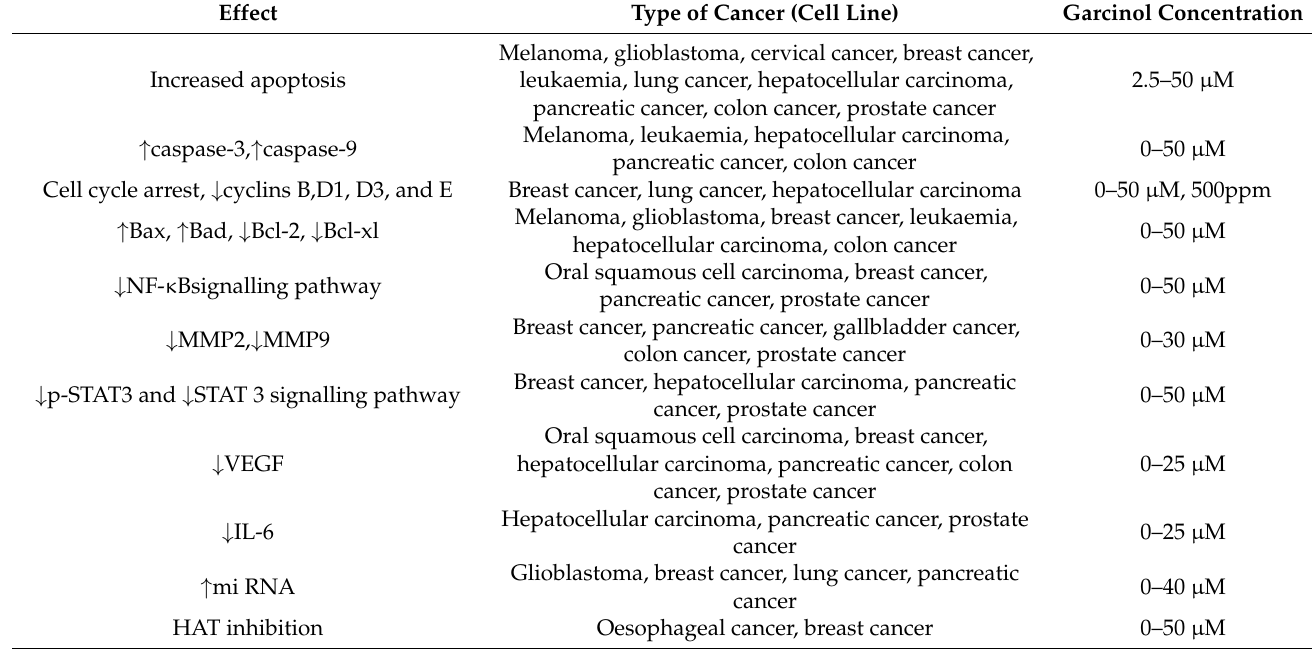
Table 3. Major anticancer effects of garcinol observed in in vitro studies. Adopted from Aggarwal